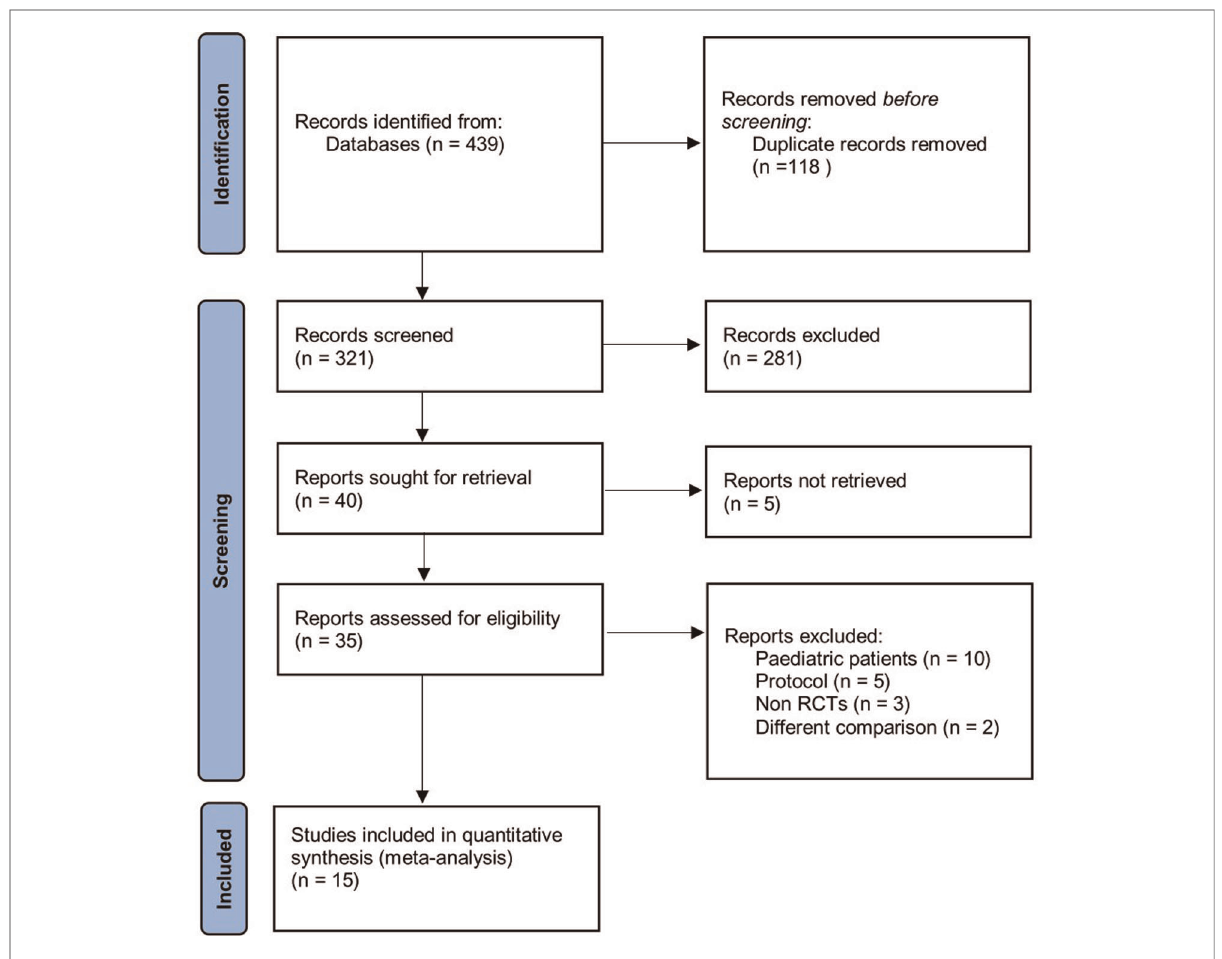
FIGURE 1 PRISMA fl ow